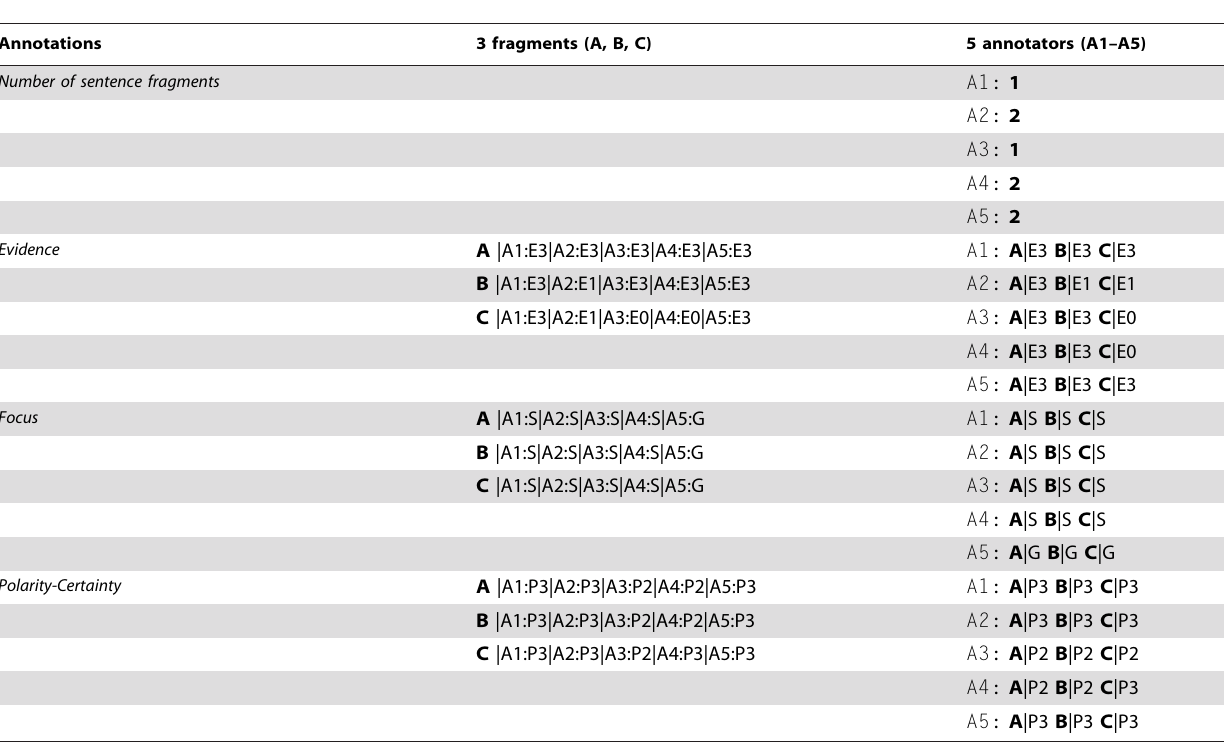
Table 1. Example of a sentence from the dataset, annotated by 5 independent annotators (sentence 10835394_70).